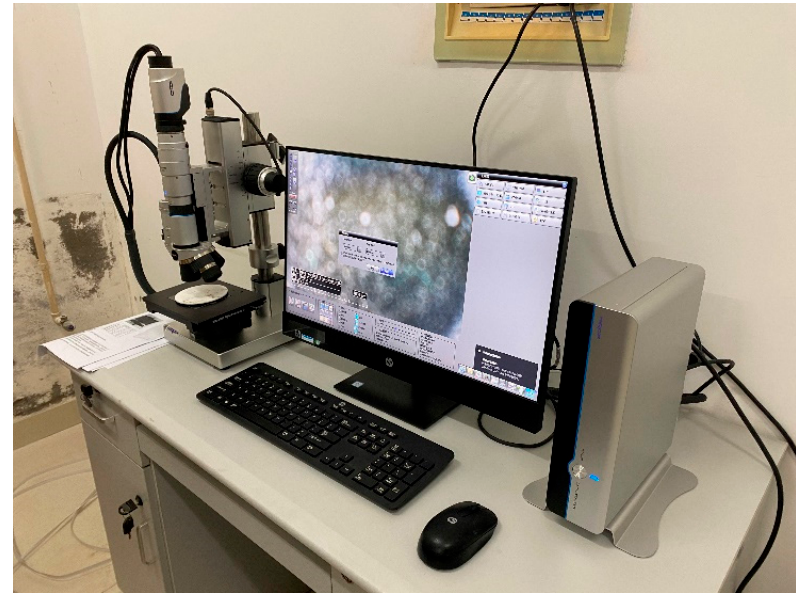
Figure 3. Three-dimensional digital microscope.